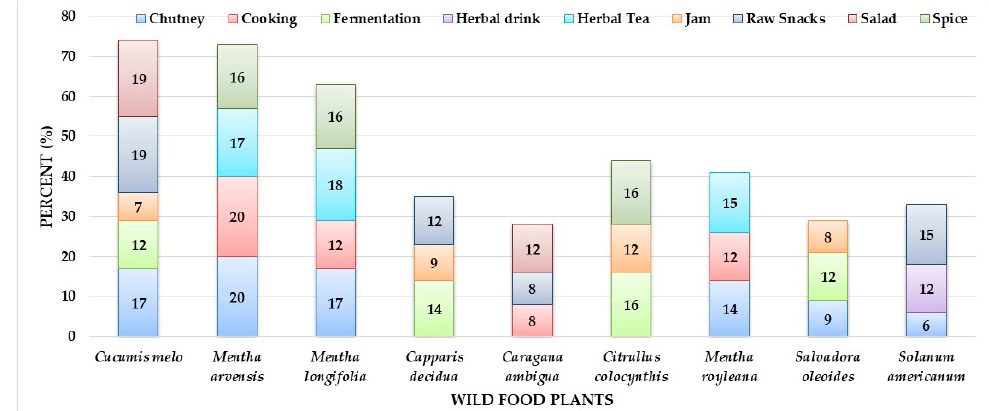
Figure 3. Most commonly used wild food plants and their